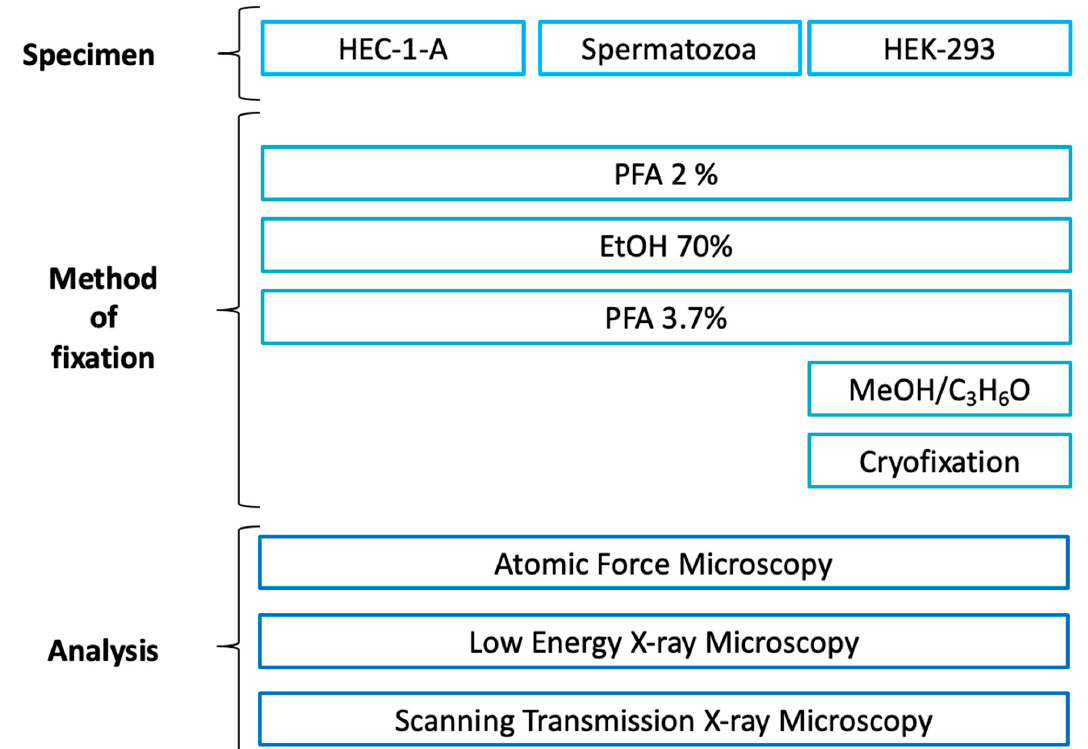
Figure 1. Experimental plan of the experiment indicating the fixation protocols used for each type of sample. Paraformaldehyde (PFA); Ethanol (EtOH); Methanol (MeOH); Acetone (C 3 H 6 O). The XRF results were compared with and complemented by the AFM